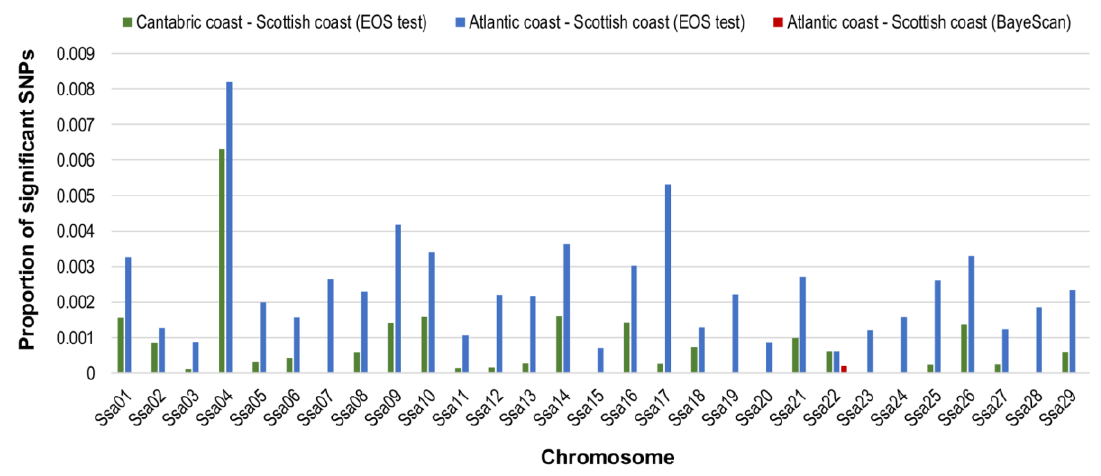
Figure 4. Proportion of significant SNPs of outliers, methods: BayeScan (log BF = 1.5) and EOS-